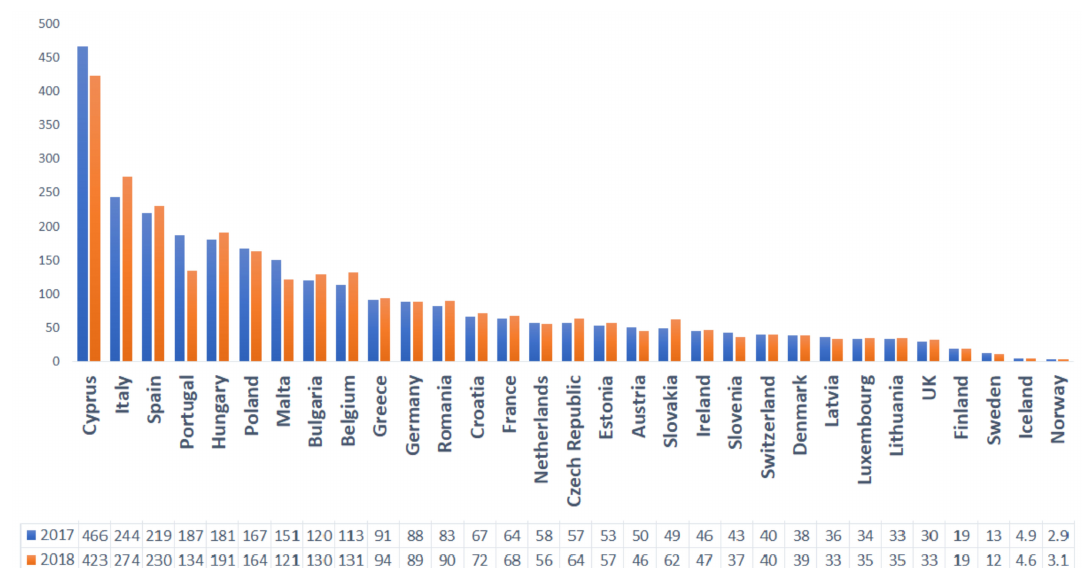
Figure 3. Total consumption (community and hospital sector) of antibacterials for systemic use (ATC group J01) by country, EU/EEA, 2018–2019 (expressed as DDD per 1000 inhabitants per day).